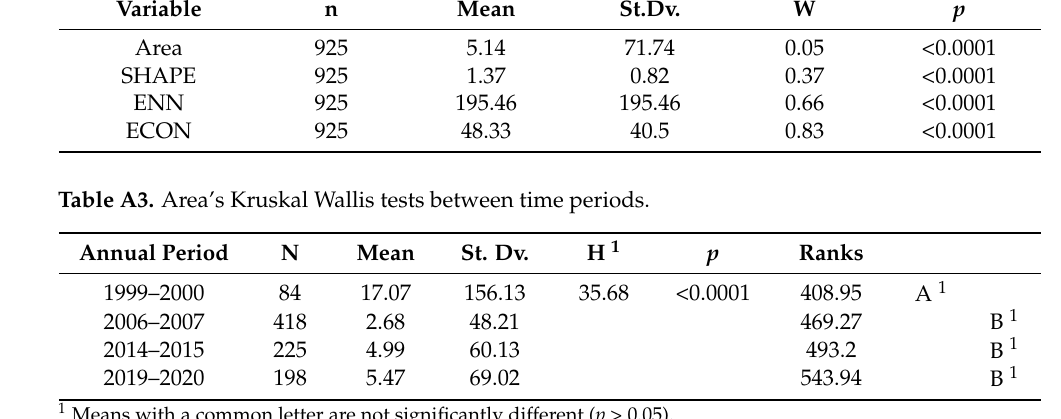
Table A4. Shape Index’s Kruskal Wallis tests between time periods .